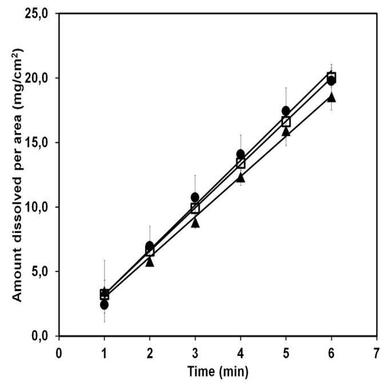
Intrinsic dissolution studies of OLZ samples A (□), B (▲) and C (●) in HCl 0.1 N.